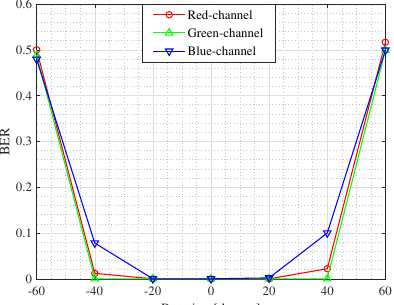
Figure 19. BER performance according to display rotation.